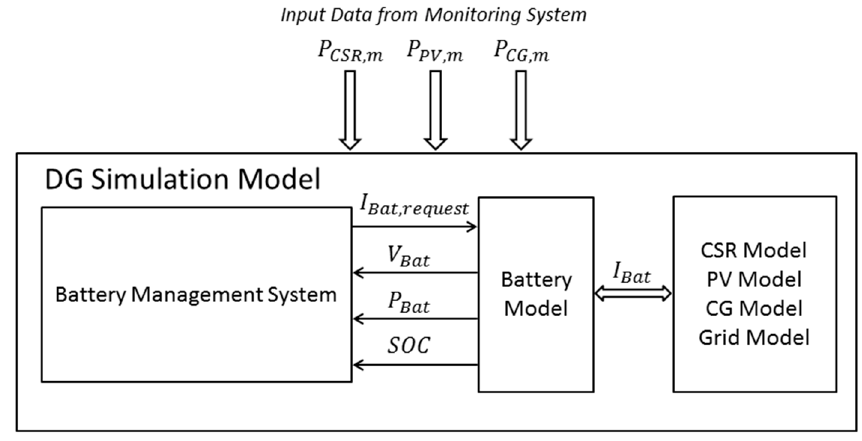
Figure 16. Block diagram DG simulation model.